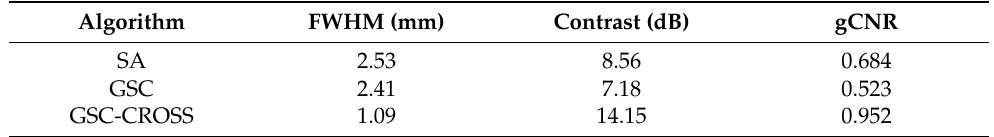
Table 3. FWHM, contrast and gCNR of different beamforming